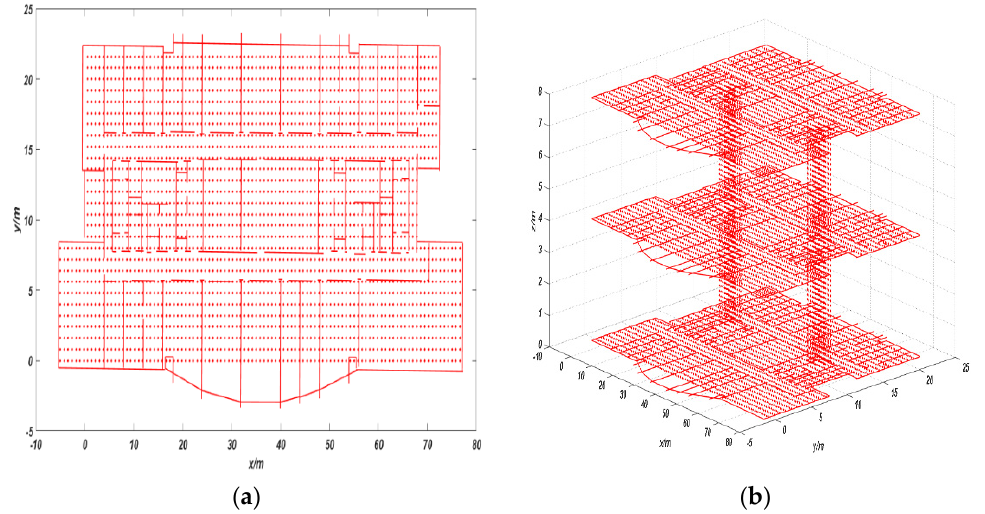
Figure 4. ( a ) Two-dimensional map with states and ( b ) three-dimensional map with states.